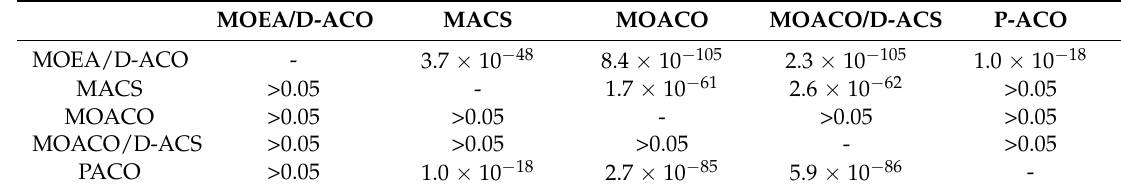
Table 6. Kruskal–Wallis test on kroCD100 based on H-indicator.